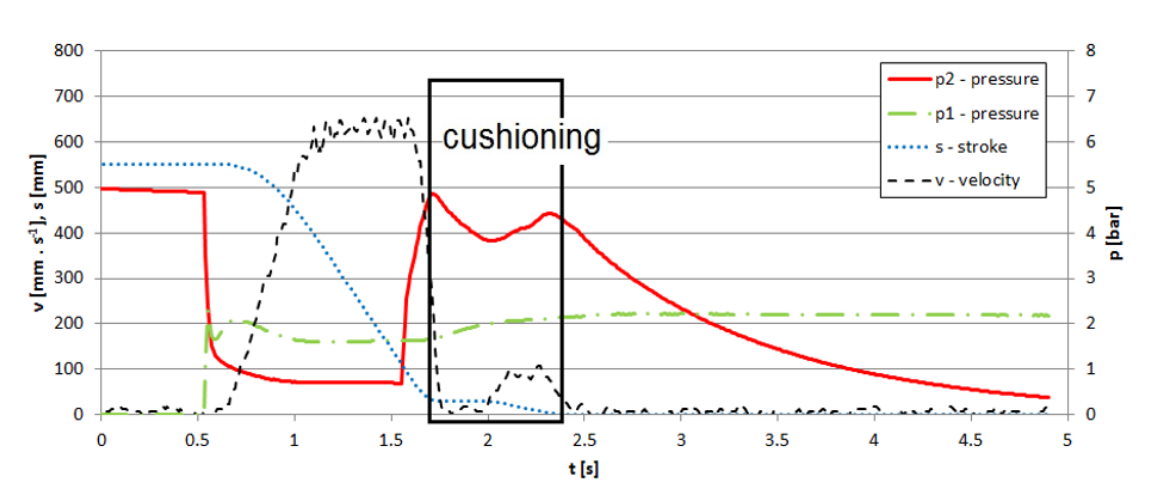
Fig. 13. Measuring results of system – optimal